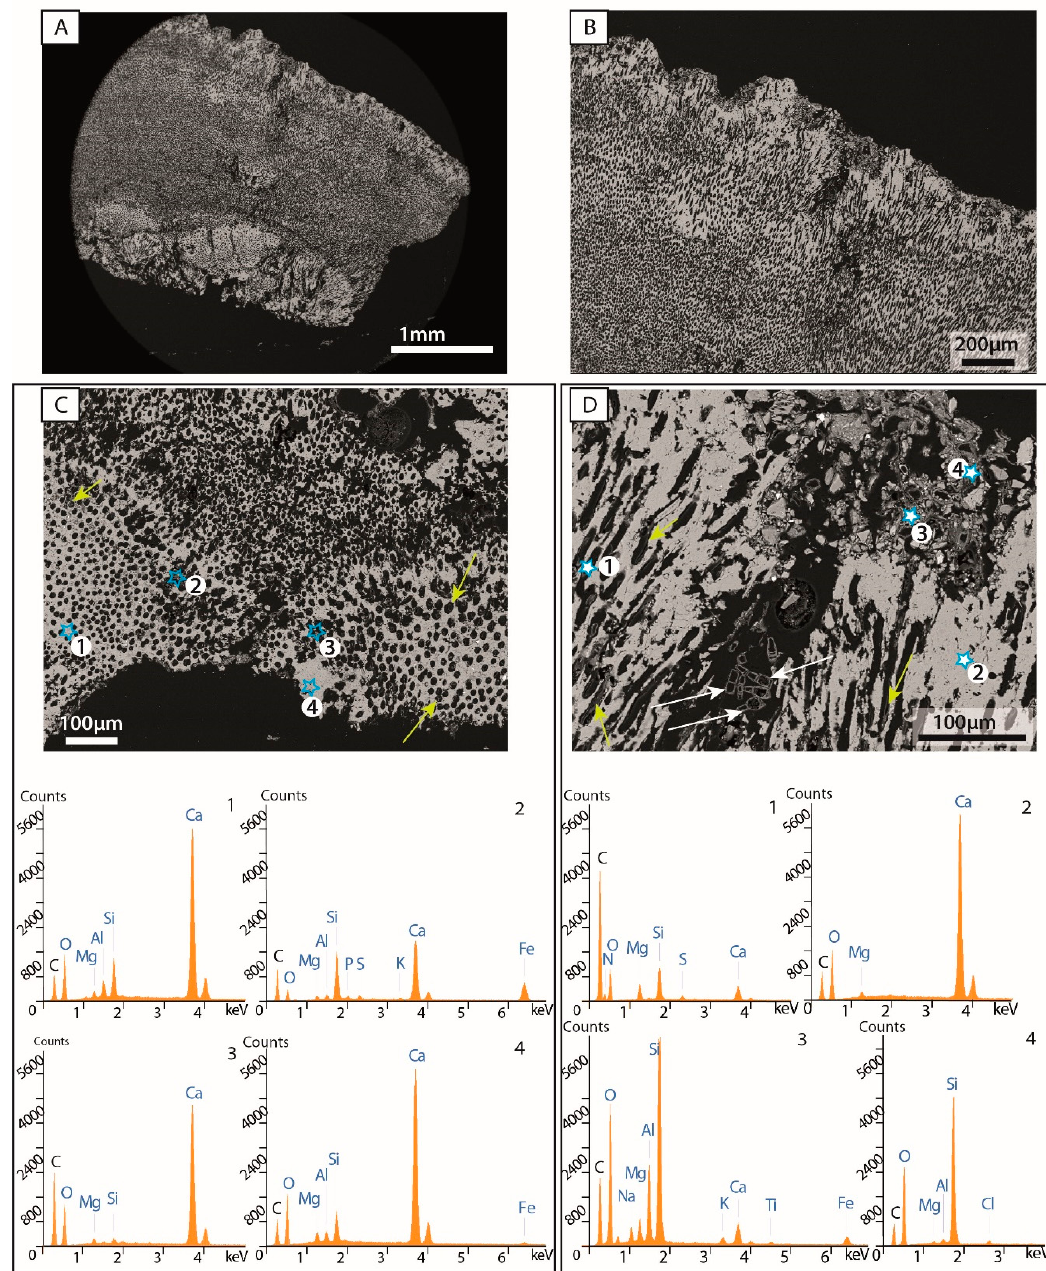
Figure 6. SEM photomicrographs and EDS analyses on thin sections of dried crusts. ( A ) SEM photomicrograph of the dense crust thin section. ( B ) Higher magnification of the upper part of the dried crust ( A ), with distinctly rounded and elongated microstructures. ( C ) SEM photomicrograph showing the positions of EDS analytical measurements with different areas of the mineralized crust (1–4). Yellow arrows point to filament remains in the rounded pores. ( D ) SEM photomicrograph showing the position of EDS analytical measurements associated with different elements: (1) filament remains, (2) carbonate crust, (3) detrital clasts and (4) detrital clasts. Yellow arrows indicate filament remains in the tubular pores, while white arrows point to diatoms.